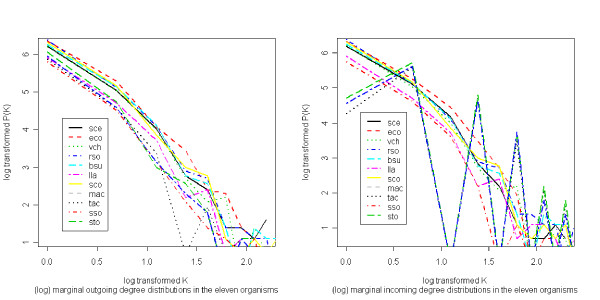
(A) Log transformed marginal outgoing degree distributions (B) Log transformed marginal incoming degree distributions in the eleven organisms